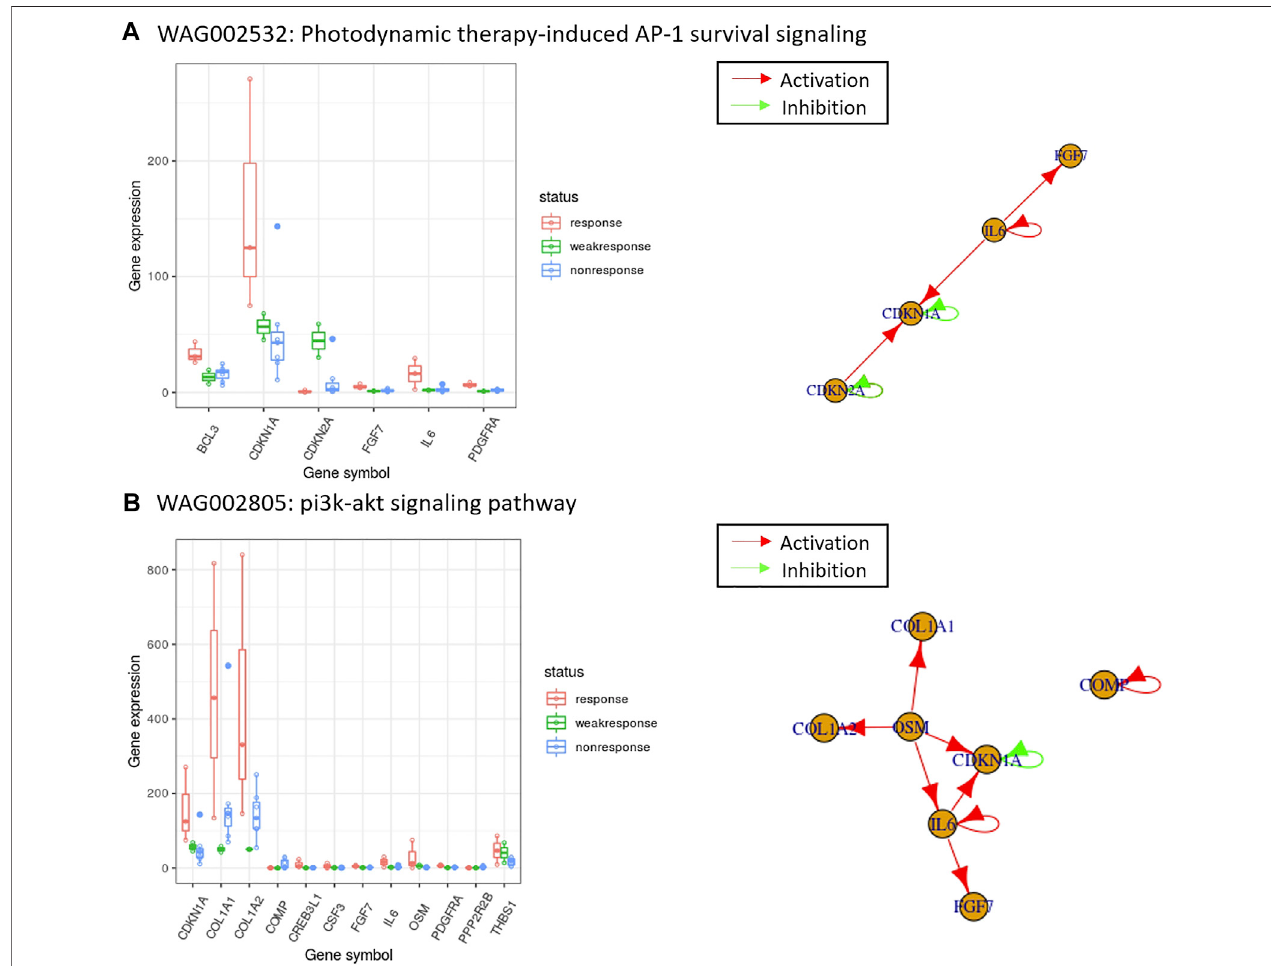
FIGURE 4 | The top-ranked enriched pathways using the PubMed score and the expression of those overlapped genes with gene regulatory networks for melanoma drug resistant-sensitive patients. In the box plots, the x -axis are the overlapped genes between differentially expressed gene candidates and pathway gene members, and the y -axis are the gene expression values. In the gene regulatory networks, a red arrow indicates the direction of activation, and a green arrow indicates the direction of inhibition. WAG002532 and WAG002805 are the PAG IDs of the enriched pathways shown in (A) The pathway with the highest PubMed score in Table 2 , and (B) one of the PubMed literature validated pathways in Table 3 . The details of pathways shown can be retrieved online from: http://discovery.informatics. uab.edu/PAGER/index.php/geneset/view/[PAG ID].